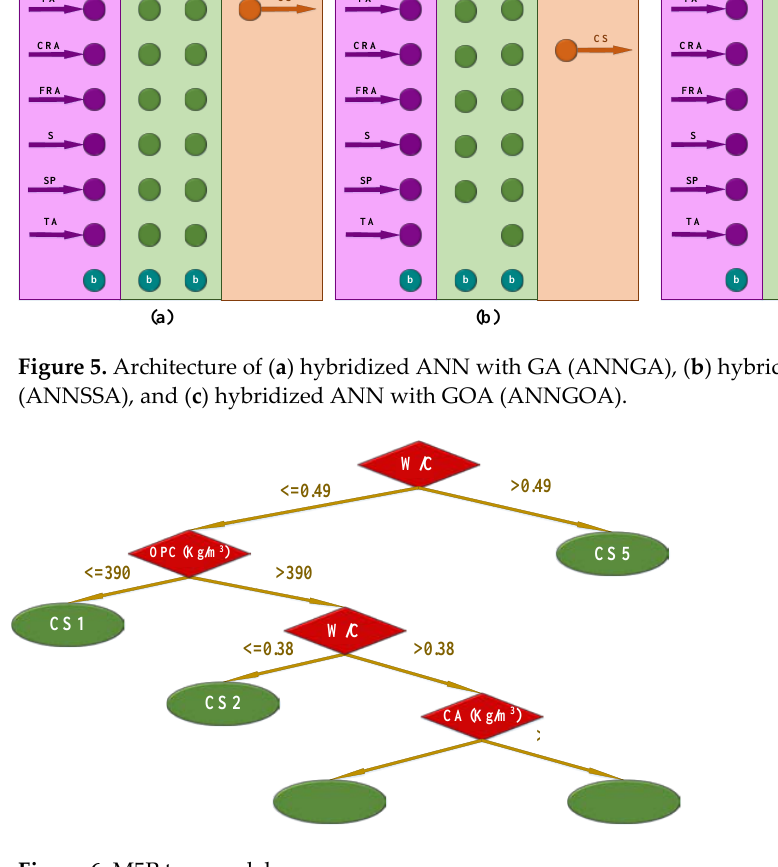
Figure 6. M5P tree